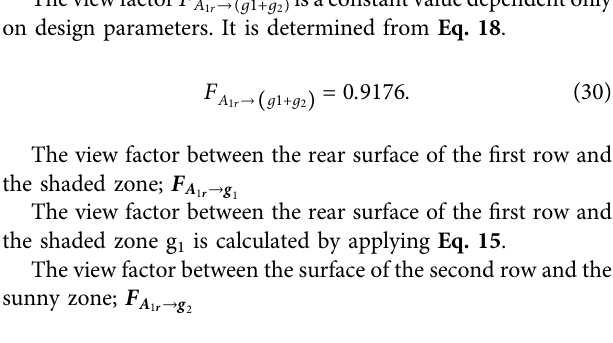
The view factor between the rear surface of the fi rst row and space-separating rows; F A → ( g 1 + g ) 1 r 2 The view factor F A → ( g 1 + g ) is a constant value dependent only 1 r 2 on design parameters. It is determined from Eq. 18 .